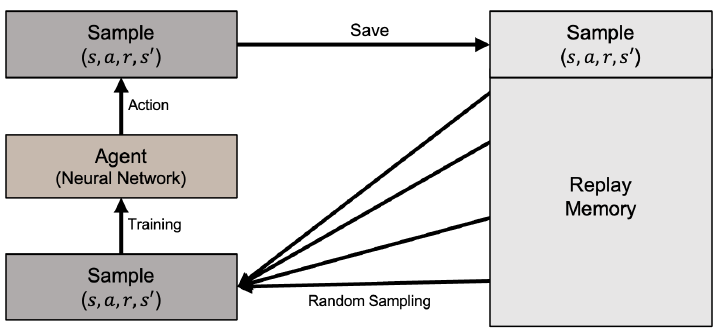
Figure 7. Illustration of DQN